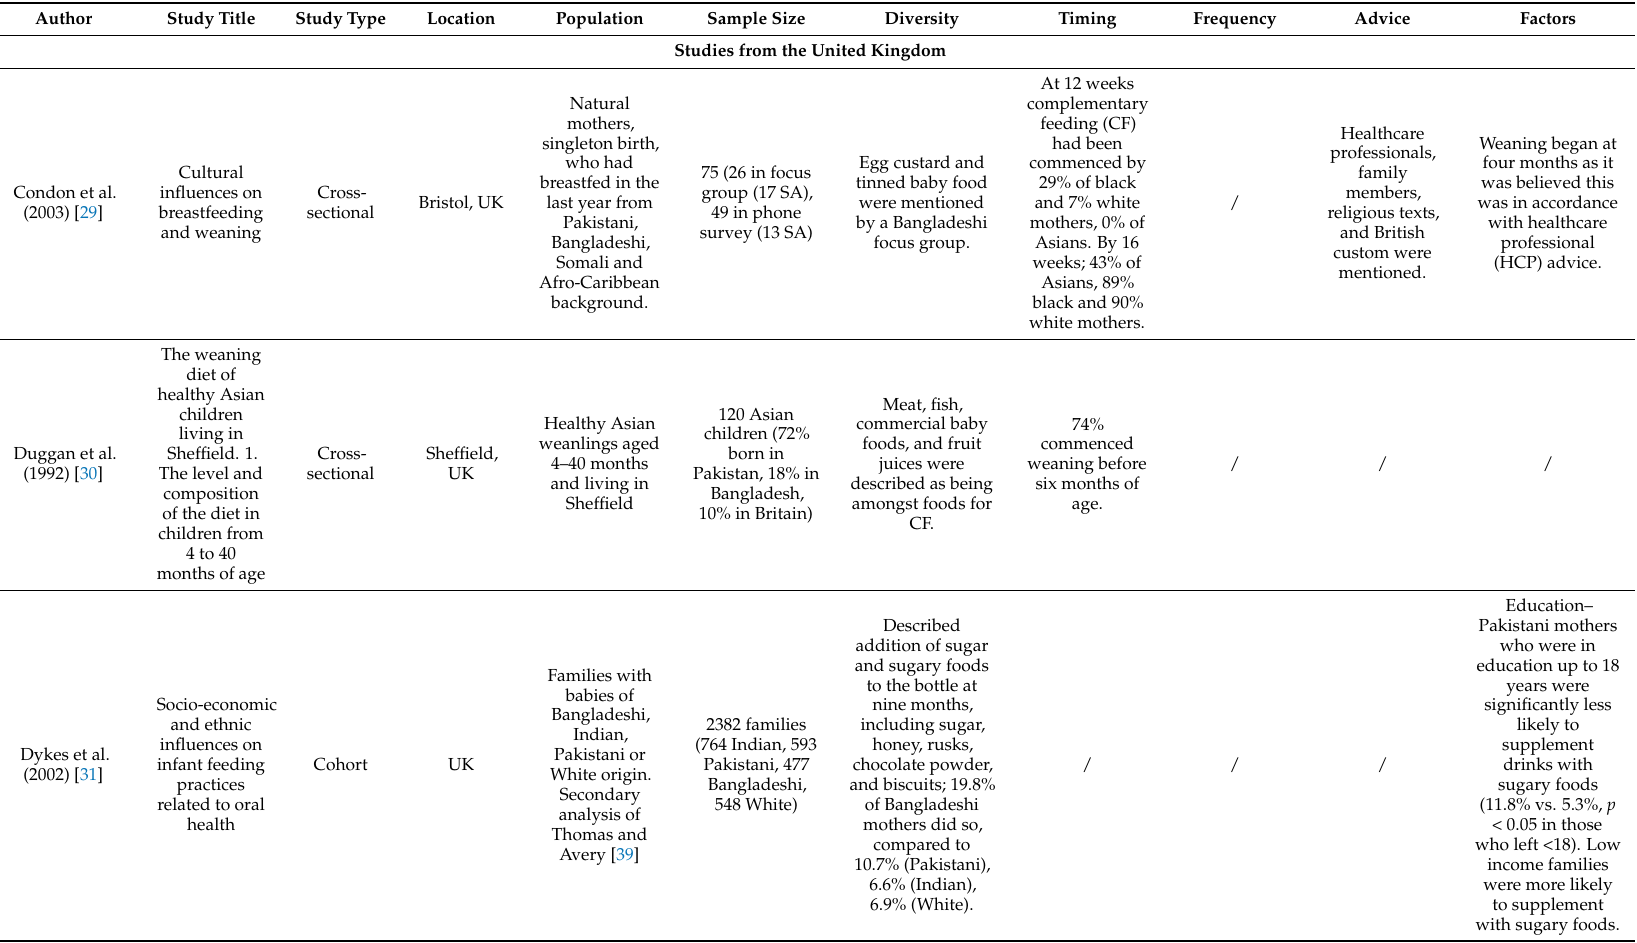
Table 2. Summary of included